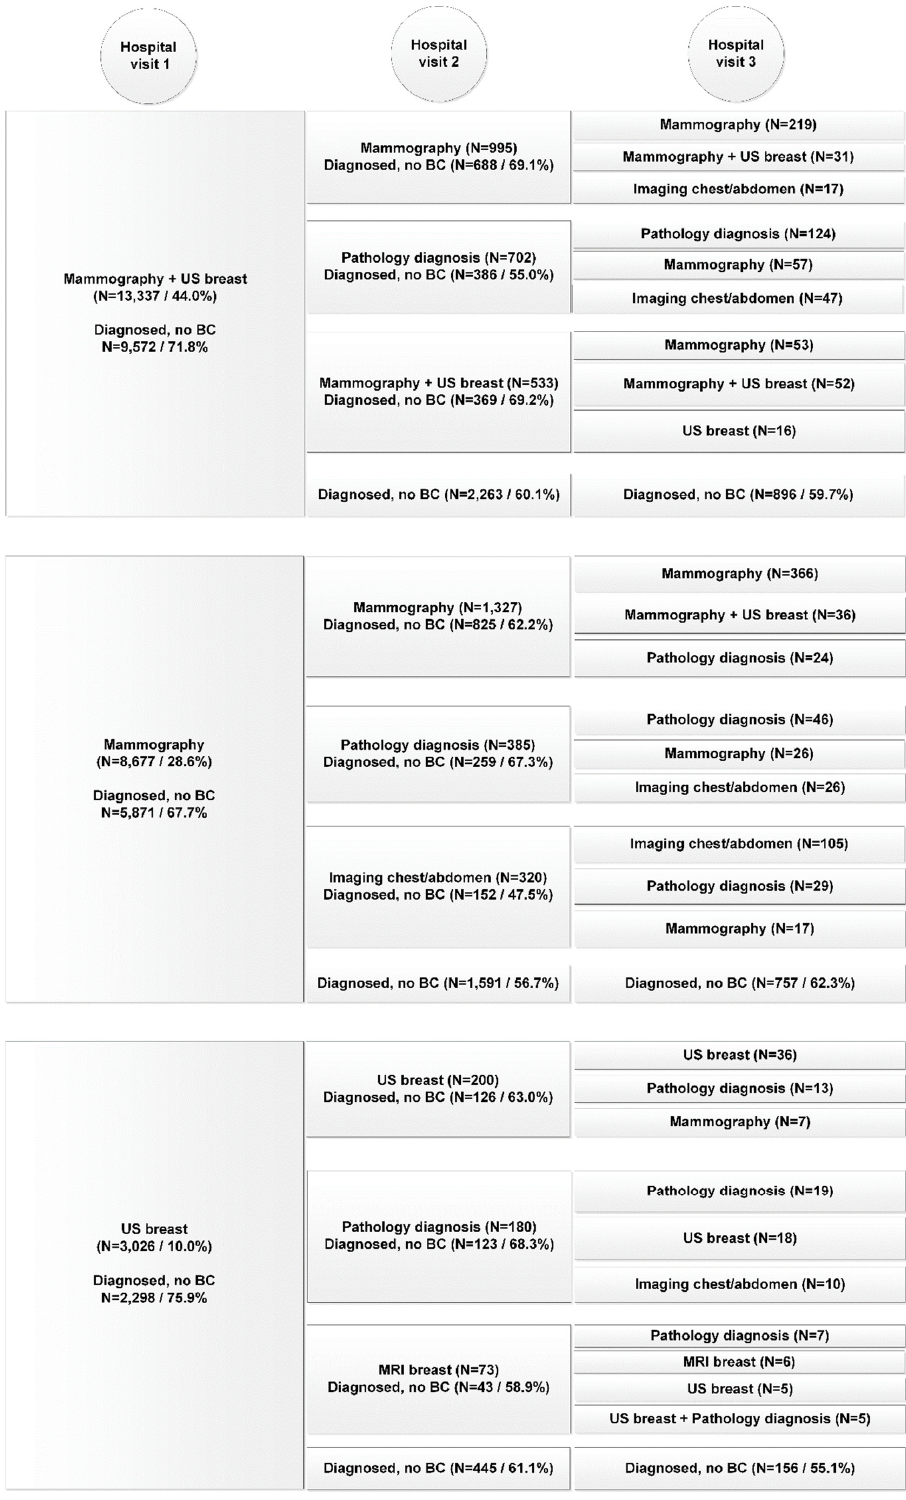
Figure 1. Diagnostic pathway per consecutive hospital visit of patients in the benign cohort ( n = 30,334).